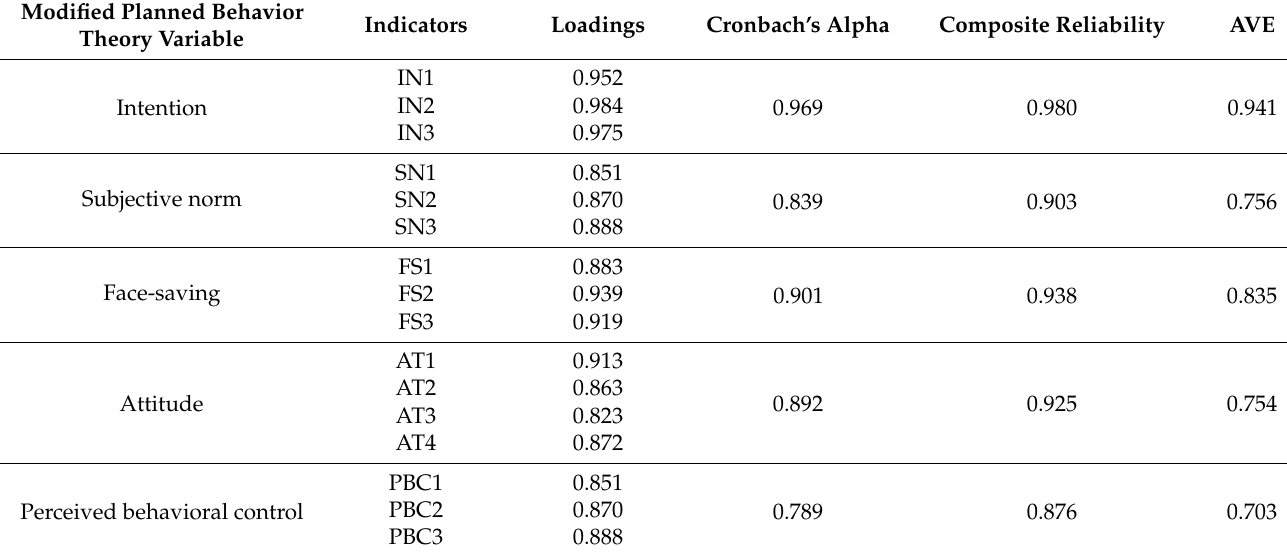
Table 3. Validity of the Modified Theory of Planned Behavior Scale.